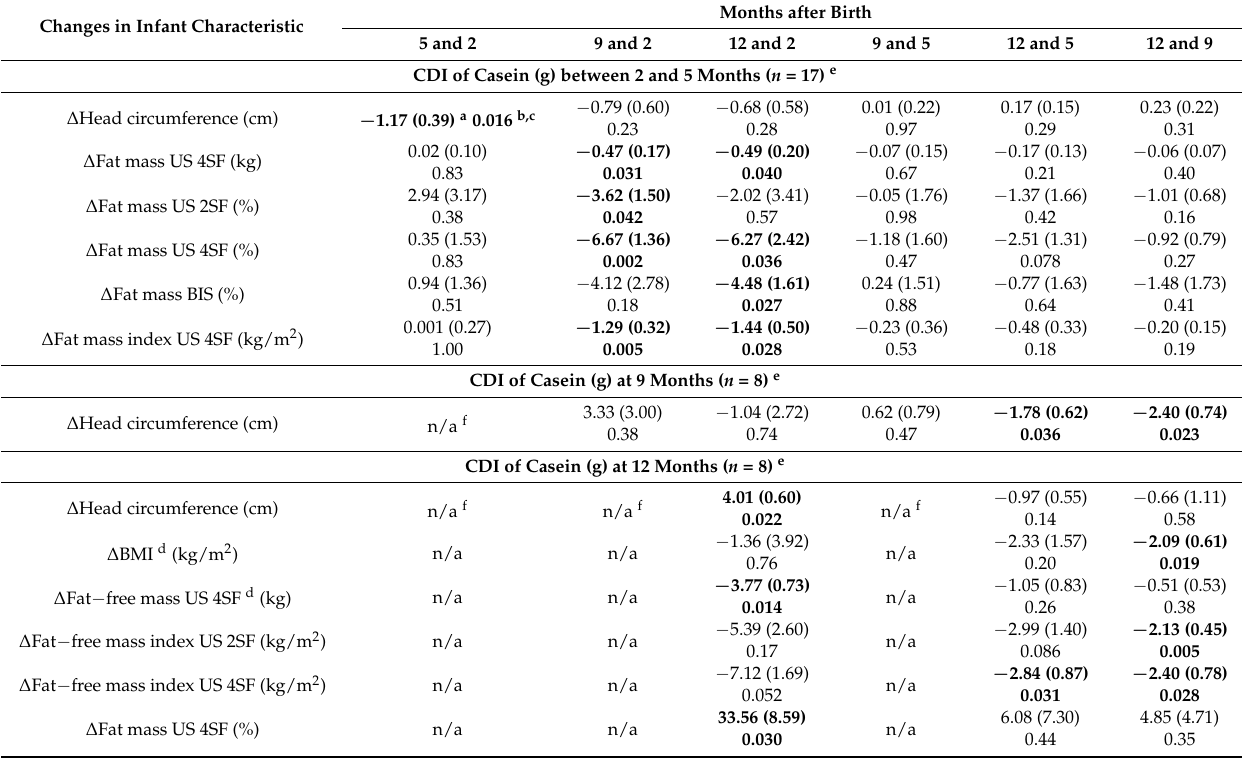
Table A6. Associations between calculated daily intakes of human milk casein at given time points and changes in infant body composition between the time points. Changes in Infant